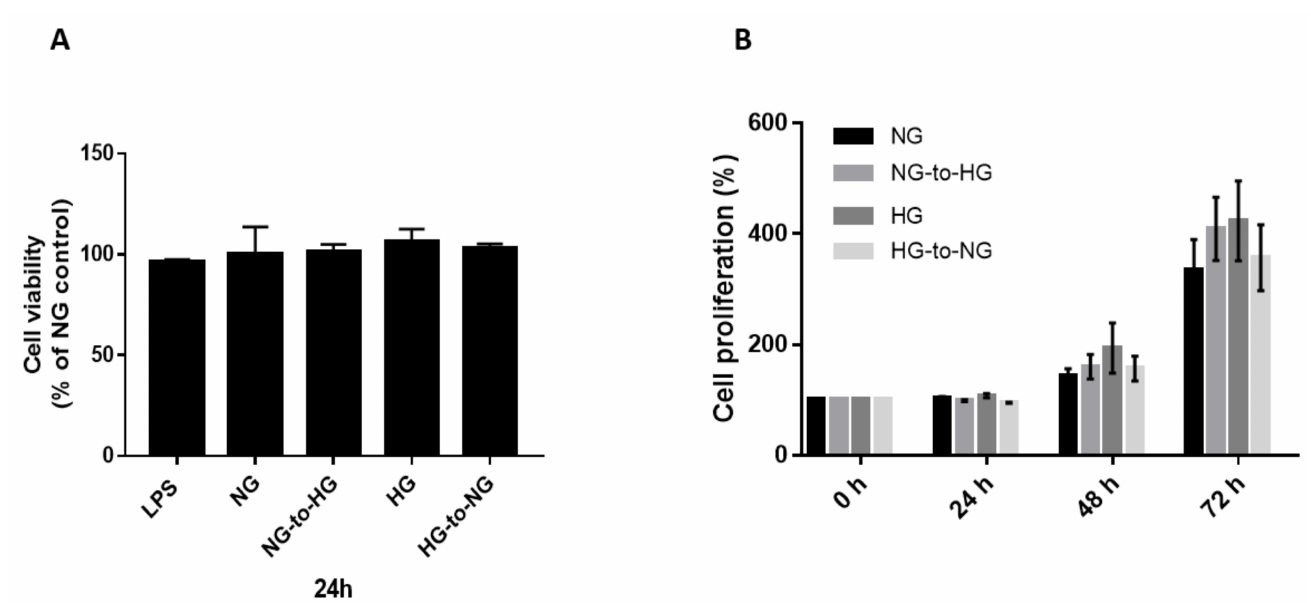
Figure 1. Effects of acute glucose shifts on cell viability and proliferative activity of THP-1 cells. ( A , B ) THP-1 cells were cultured separately in normal glucose (NG, 5.5 mM) and high glucose (HG, 25 mM). Some of them were exposed to a glucose shift (NG-to-HG or HG-to-NG). Lipopolysaccharide (LPS, 1 µ g/mL) was used as a positive control. Cell viability and proliferation were assesses at the indicated incubation time points. Data are expressed as the mean ± SEM. The cell survival ratio is expressed as a percentage of the NG